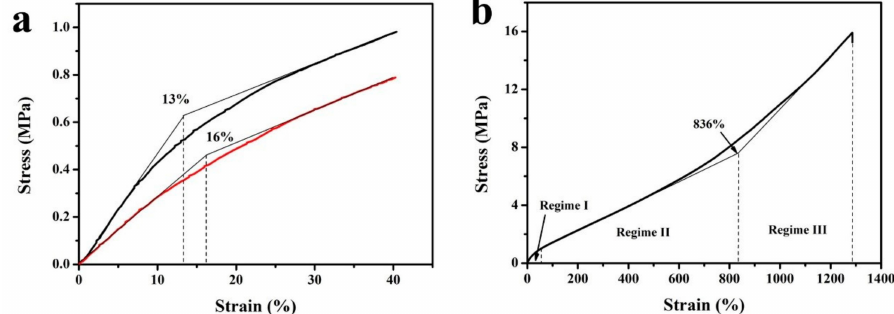
Figure 6. ( a ) Initial stress-strain curves of PUU-Py0 / 1 (red) and PUU-Py1 / 4 (black) demonstrating Young’s modulus di ff erence; ( b ) divided regimes of stress-strain curve for PUU-Py1 /